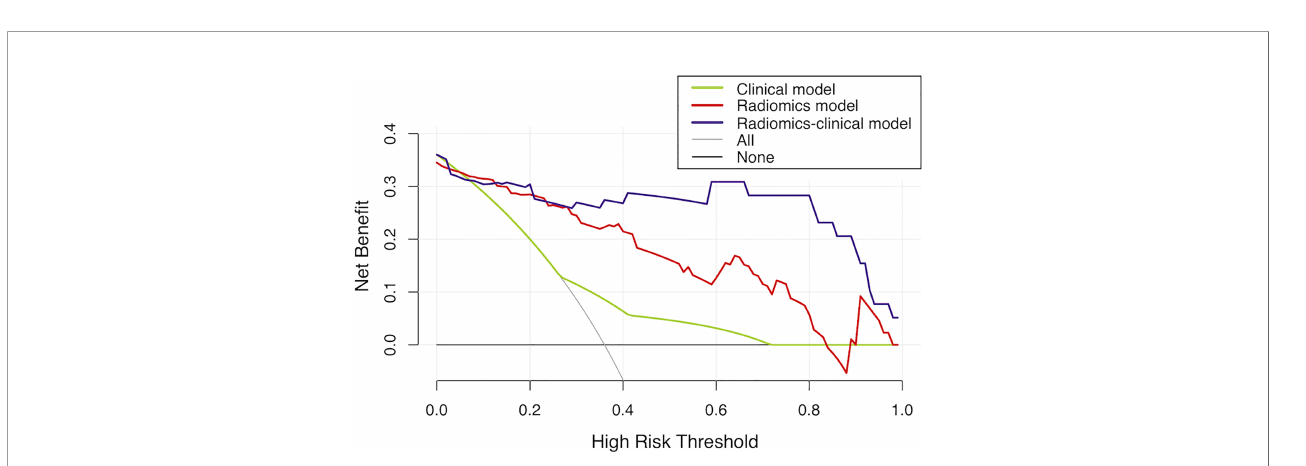
FIGURE 5 | Decision curve analysis for the models in the validation set. It can be concluded that when the threshold probability is over 30% approximately, the radiomics-clinical model could provide extra pro fi ts over the “ treat-all ” or “ treat-none ” scheme, the combined radiomics signature, and the clinical